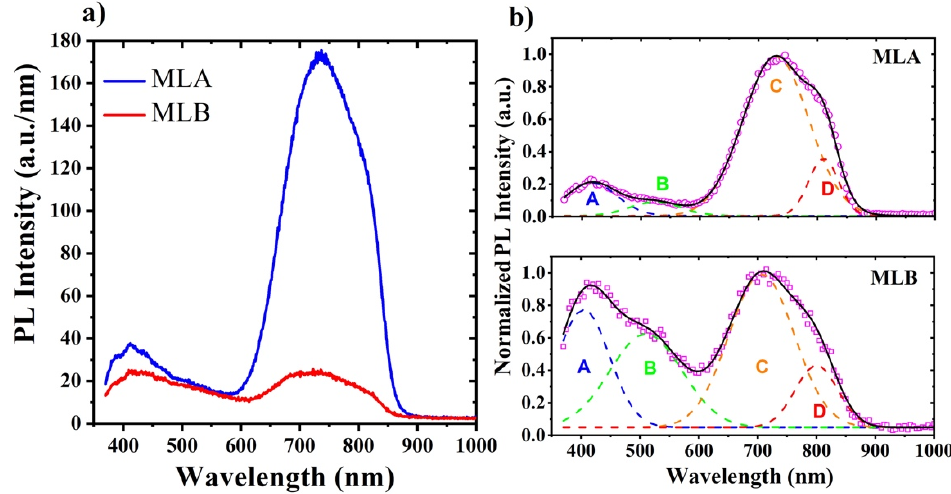
Figure 5. ( a ) PL spectra of MLA and MLB, and ( b ) deconvolution of the PL peaks for both MLs. It was observed that both MLs presented a broad emission spectrum, which could be divided into two main ranges: one from 370 to 590 nm and the other from 590 to 870 nm.